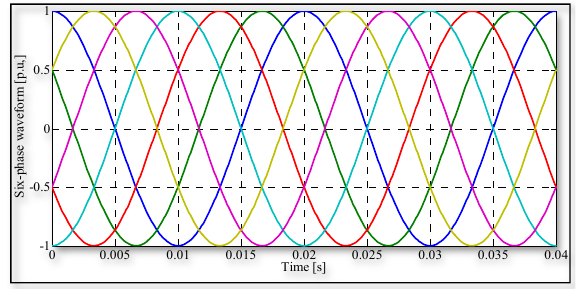
Electronics 2019 , 8 , 109